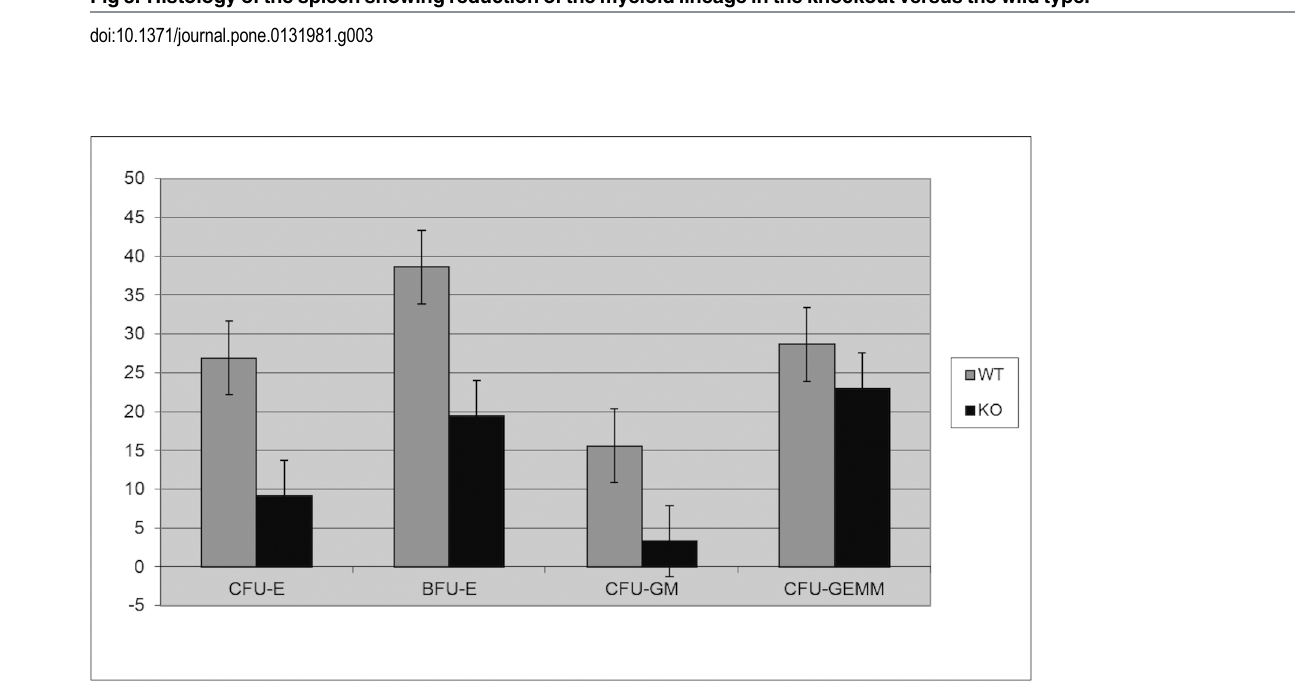
PLOS ONE | DOI:10.1371/journal.pone.0131981 July 6, 2015 6 /